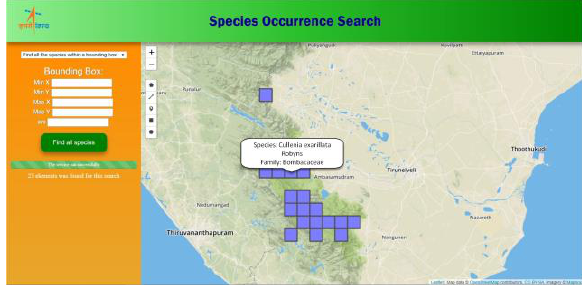
Figure 5. WPS Web Client- Output of Species Occurrence Search using user defined Bounding Box